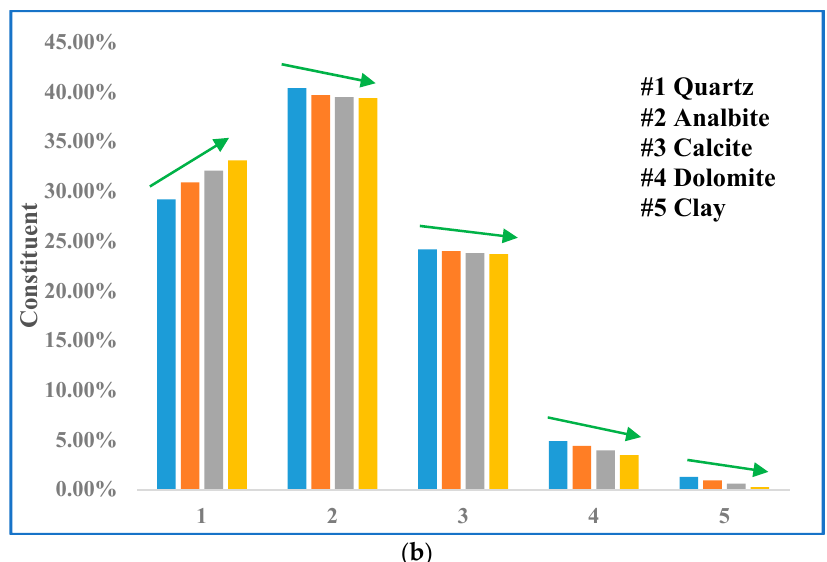
Figure 9. Mineral content alteration with varied Sc-CO 2 injection time. ( a ) sample at depth of 9848 ft; ( b ) sample at depth of 9850 ft.